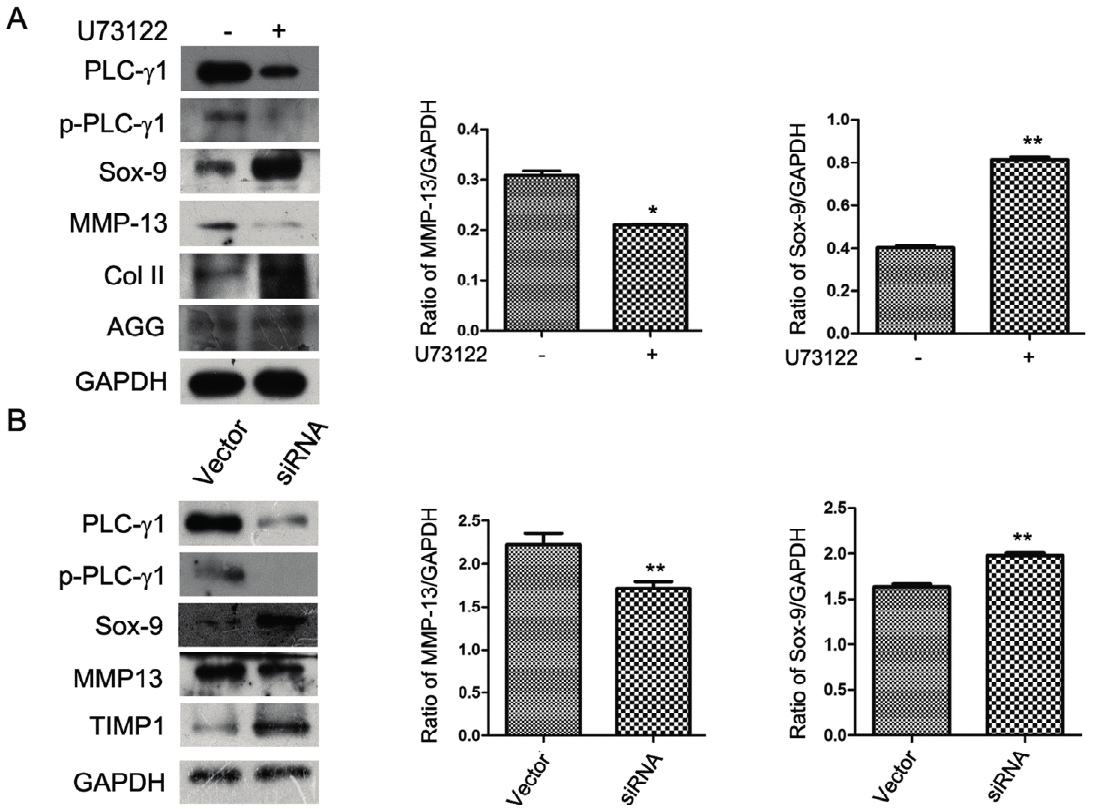
Figure 2. The extracellular matrix (ECM) synthesis of OA chondrocytes partially depends on PLC- γ 1 activation. OA chondrocytes were obtained from 16 patients with advanced OA. ( A ) Cultured cells were treated with or without U73122 (5 μ M) for 3 h, and the protein expression levels of PLC- γ 1, p-PLC- γ 1, Sox-9, MMP-13, Col II, and AGG were detected by western blotting analysis using rat anti-PLC- γ 1, p-PLC- γ 1, Sox-9, MMP-13, Col II, AGG, and GAPDH antibodies; ( B ) Cultured cells were transfected with or without siRNA-PLC- γ 1, and the protein expression levels of PLC- γ 1, p-PLC- γ 1, Sox-9, MMP-13, and TIMP1 were detected by western blotting using rat anti-PLC- γ 1, p-PLC- γ 1, Sox-9, MMP-13, TIMP1, and GAPDH antibodies. The values represent the mean ±S.E.M. of three to five independent experiments, each yielding similar results ( * p < 0.05, ** p <